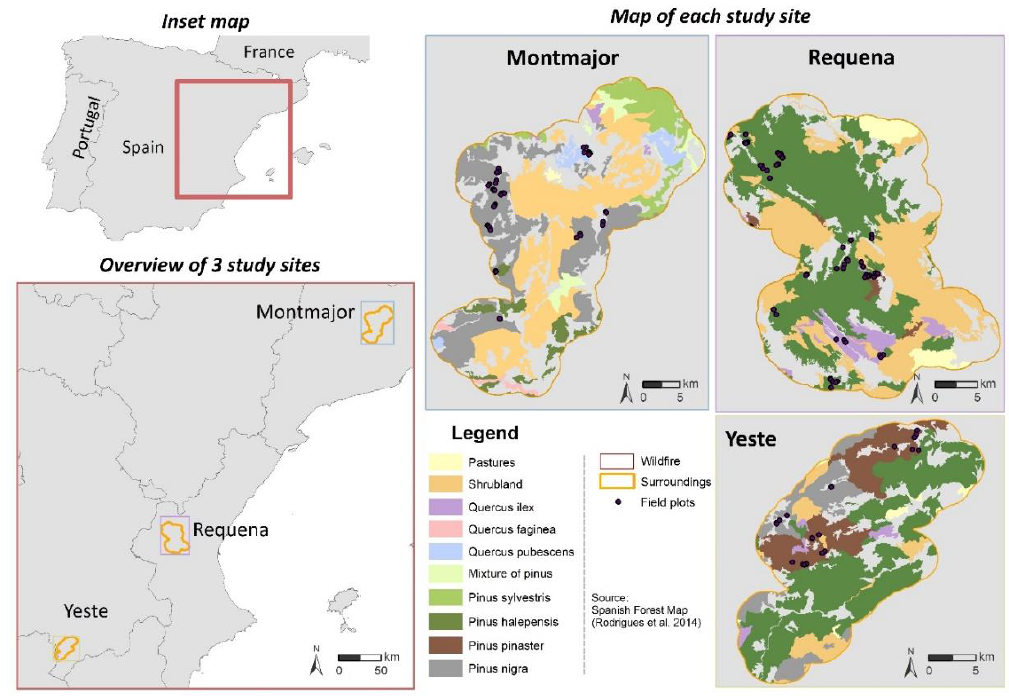
Figure 1. Study area with the location of areas affected by wildfires, surrounding areas, field plots and pre-fire vegetation.